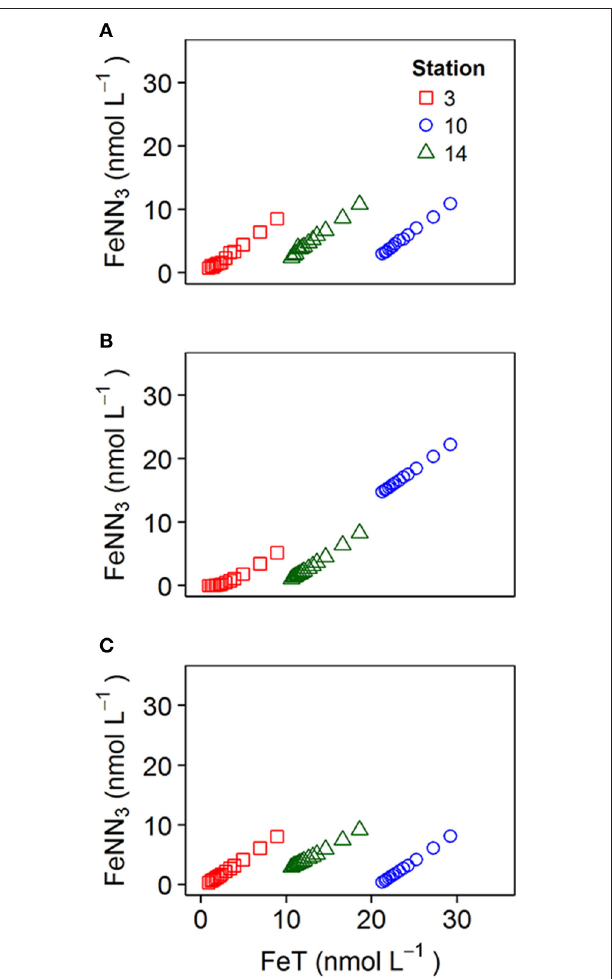
FIGURE 5 | Iron competitive ligand equilibrium titrations at pH 8.0 (A) observed for station 3, 10, and 14, (B) simulated using dissolved organic matter calculated with NICA-Donnan parameters only considering organic complexation and (C) simulated using NICA-Donnan parameters and incorporating an insoluble inert iron phase represented by ferrihydrite.